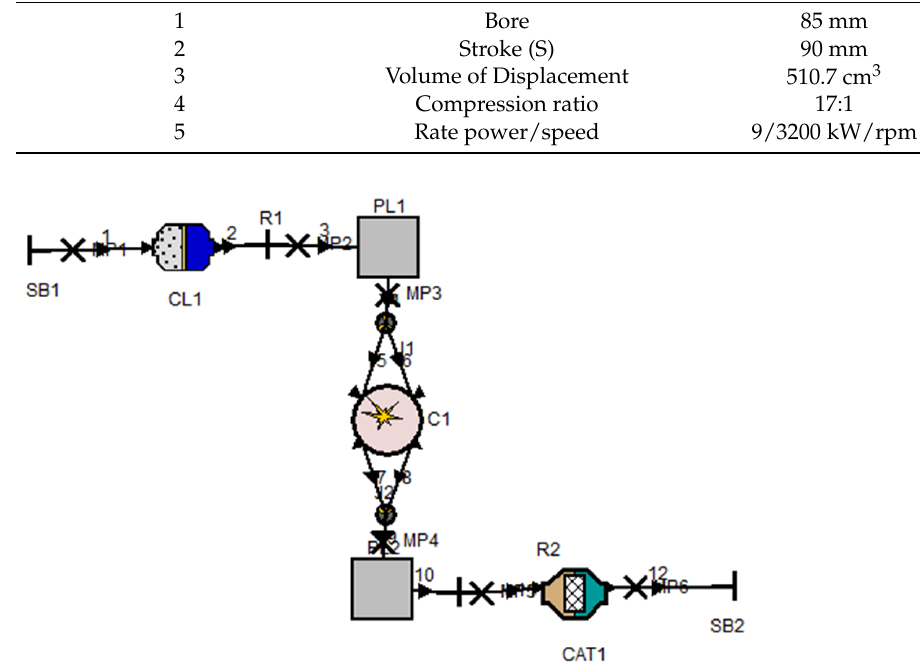
Figure 1. Engine simulation model. SB i : system boundary; CL 1 : air cleaner; R i : restriction, PL i : plenum; C 1 : Cylinder; CAT 1 : Catalyst; Mi: measuring points. Simulation Model of Heat Tranfer Table 1. Specifications of the engine.